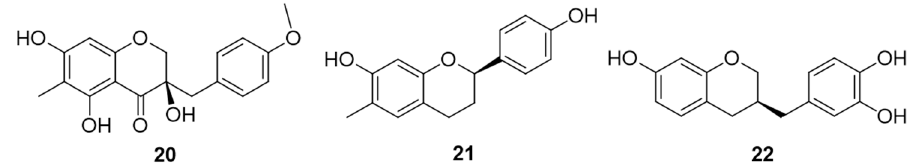
Figure 5. Chemical structures of compounds 20 – 22 isolated from D. cambodiana.